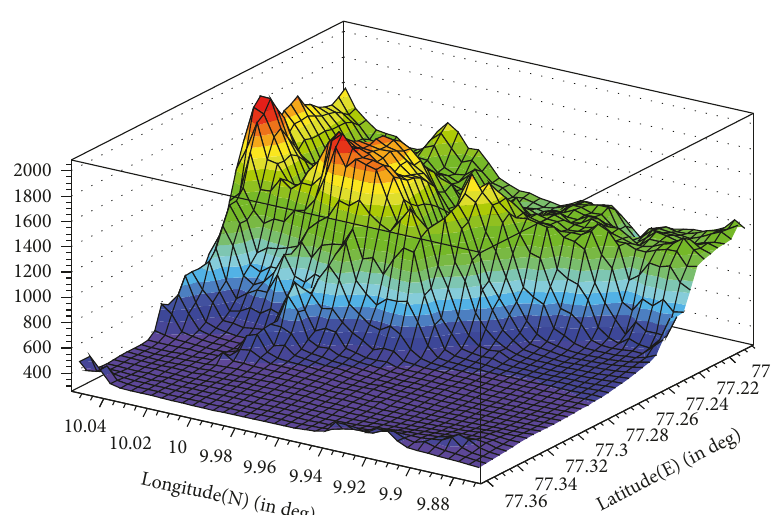
Figure 2: 3D plot of mountain surrounding (range 10 km ) around the INO-ICAL cavern